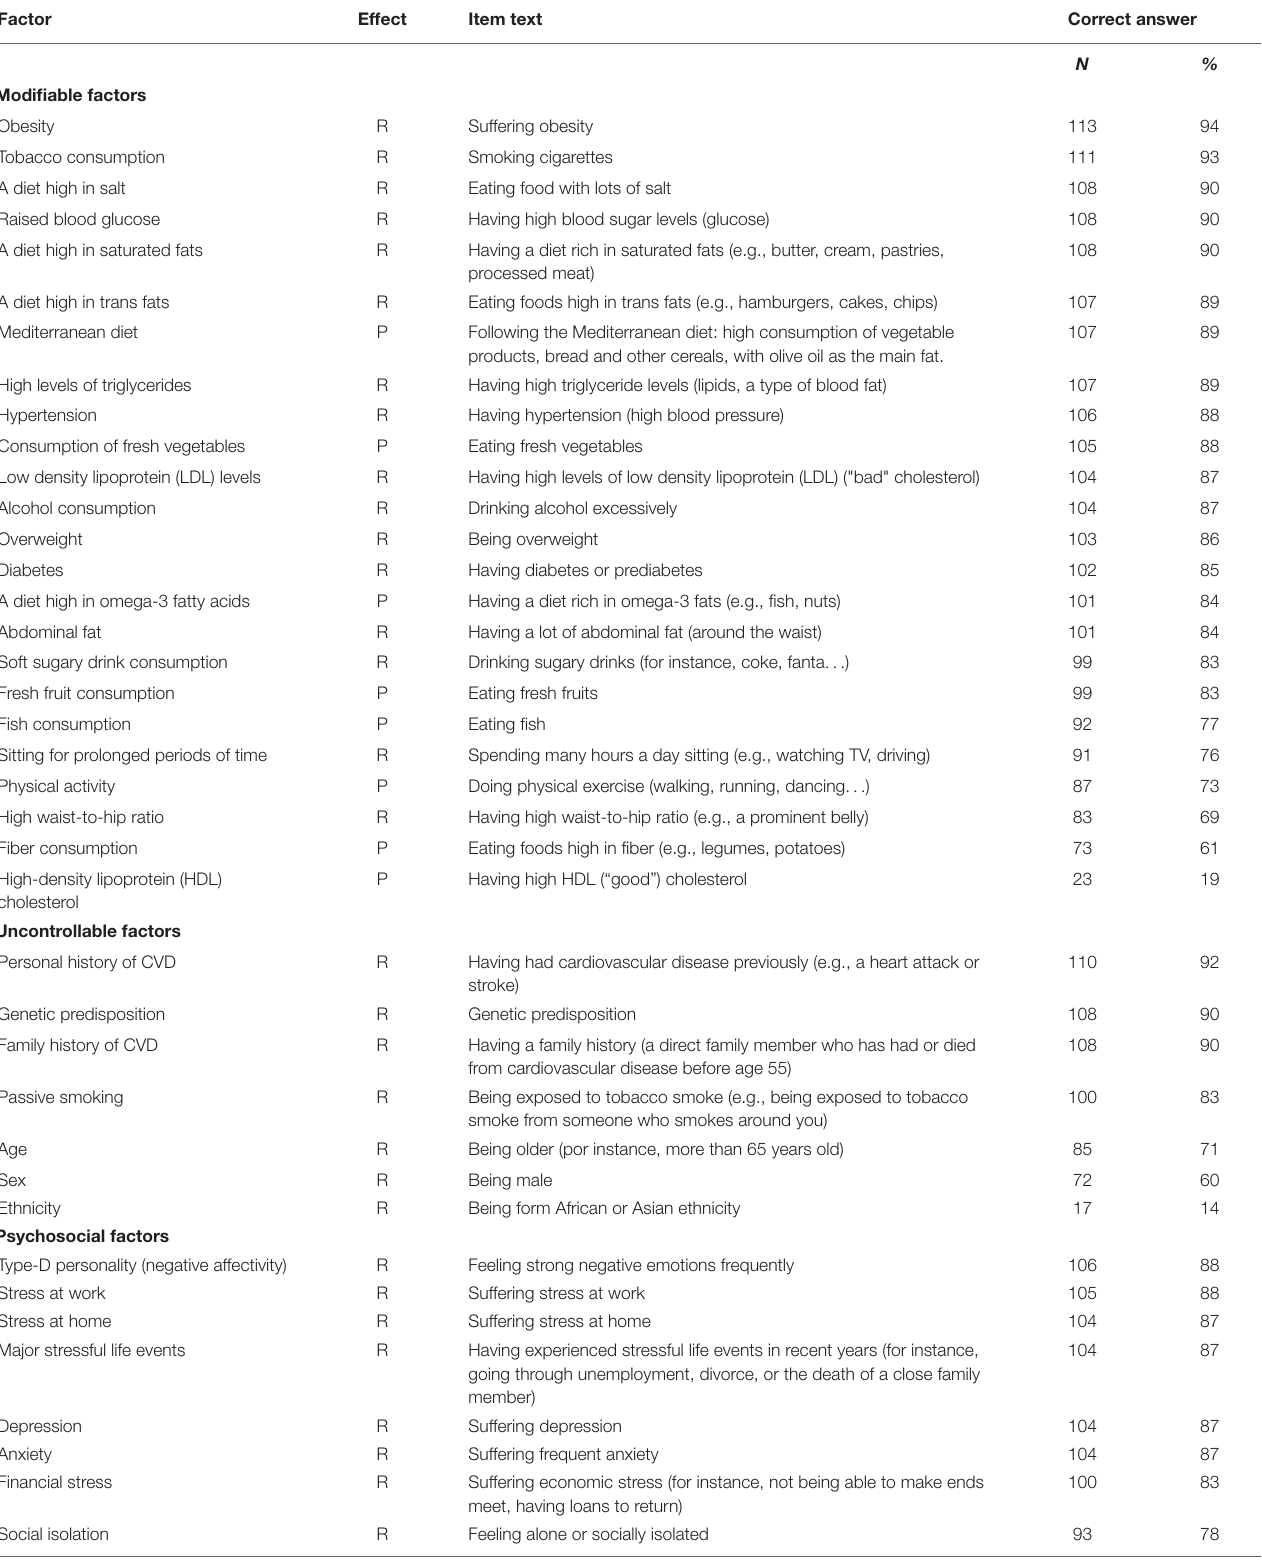
TABLE 3 | Knowledge of cardiovascular risk factors questionnaire: item